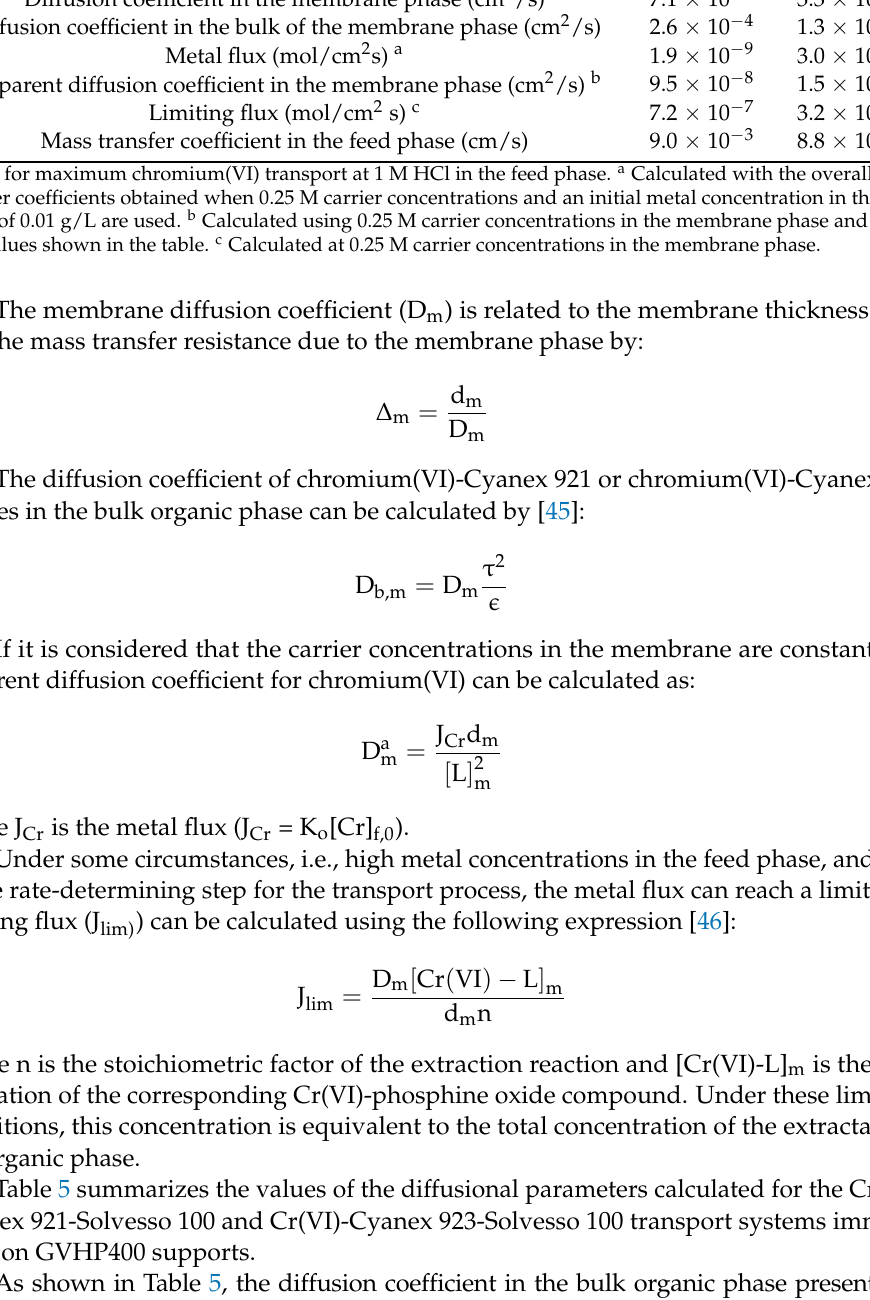
Table 5. Diffusional parameters of the Cr(VI)-Cyanex 921 and Cr(VI)-Cyanex 923 − transport systems. Parameter Cyanex 921 Cyanex 923 Mass transfer resistance due to membrane phase (s/cm) 175 396 Mass transfer resistance due to feed phase (s/cm) 111 114 Diffusion coefficient in the membrane phase (cm 2 /s) 7.1 × 10 − 5 3.3 × 10 − 5 Diffusion coefficient in the bulk of the membrane phase (cm 2 /s) 2.6 × 10 − 4 1.3 × 10 − 4 Metal flux (mol/cm 2 s) a 1.9 × 10 − 9 3.0 × 10 − 9 Apparent diffusion coefficient in the membrane phase (cm 2 /s) b 9.5 × 10 − 8 1.5 × 10 − 7 Limiting flux (mol/cm 2 s) c 7.2 × 10 − 7 3.2 × 10 − 7 Mass transfer coefficient in the feed phase (cm/s) 9.0 × 10 − 3 8.8 × 10 −